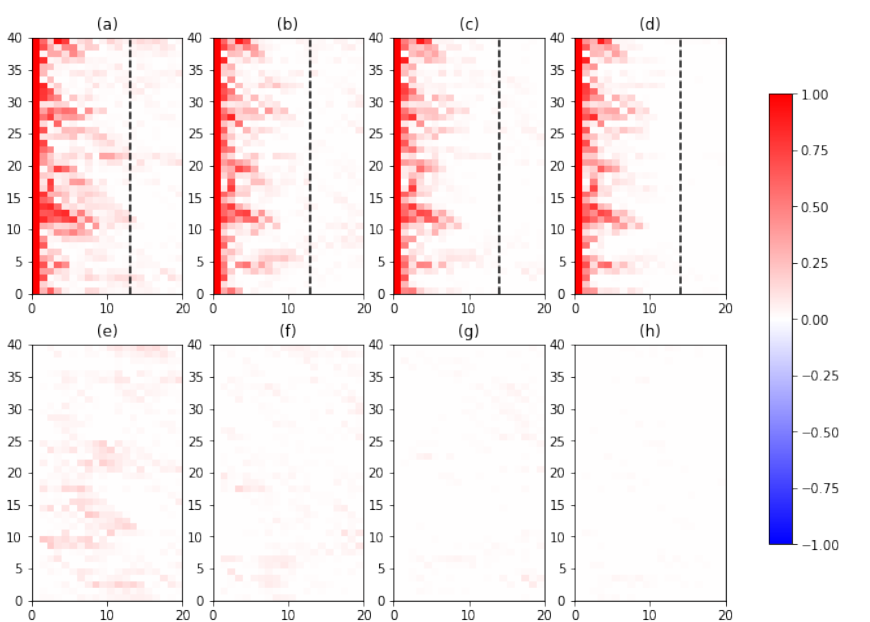
Figure 3. The square of the correlation coefficient in the Lorenz96 model with ( a ) 50 members, ( b ) 100 members, ( c ) 200 members and ( d ) 400 members. ( e – h ) represent the spurious correlation squares, respectively.